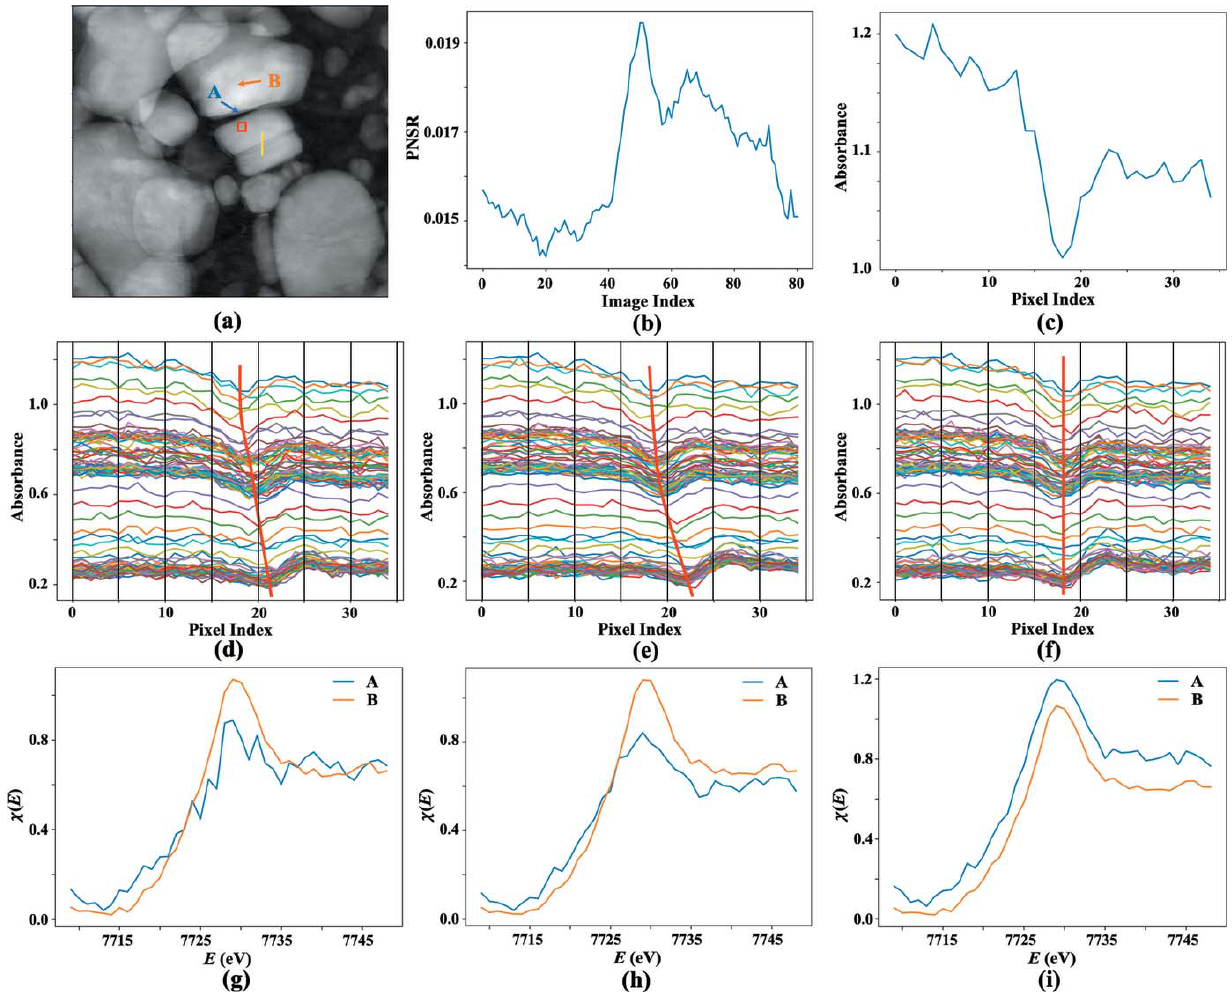
Figure 6 Registration results with a TXM XANES dataset. ( a ) Global reference image. ( b ) Average Poisson noise-to-signal ratio as a function of image index in the region of interest marked with the red box in ( a ). ( c ) Line plot along the line in ( a ). The dip position indicates the crack position in the line. ( d )–( f ) Line plots for each image in the dataset after the registrations with FPC, SSD and TVDM, respectively. With an ideal registration, the dip positions in all the lines should be the same. ( g )–( i ) XANES spectra at points A and B marked in ( a ) based on aligned image stacks with FPC, SSD and TVDM, respectively. Alignment errors have more impact on the spectra in the particles’ boundary